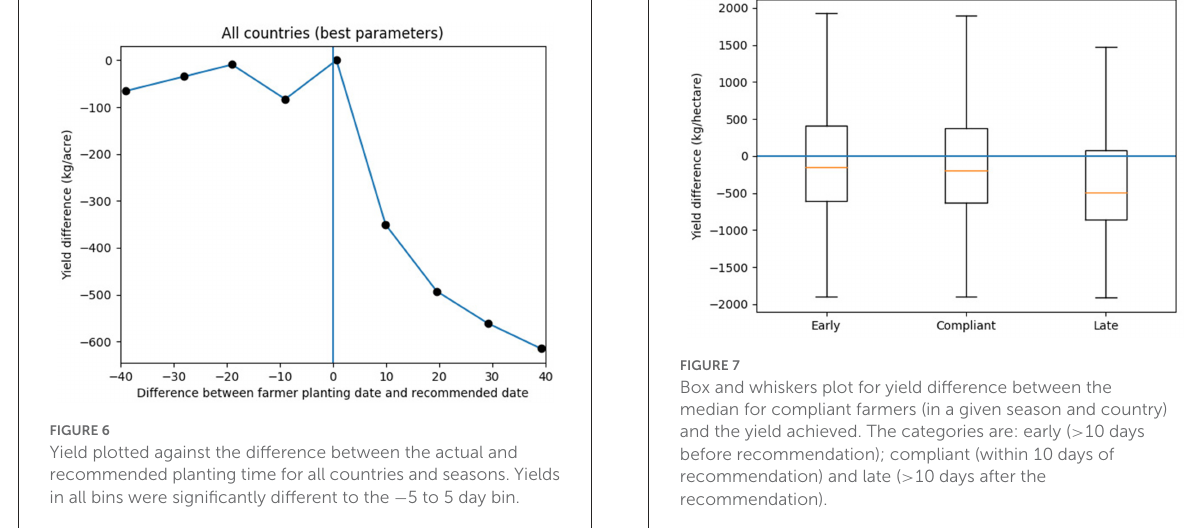
TABLE 1 Comparison between yield achieved and the difference between the observed and recommended planting dates. Median difference from recommended